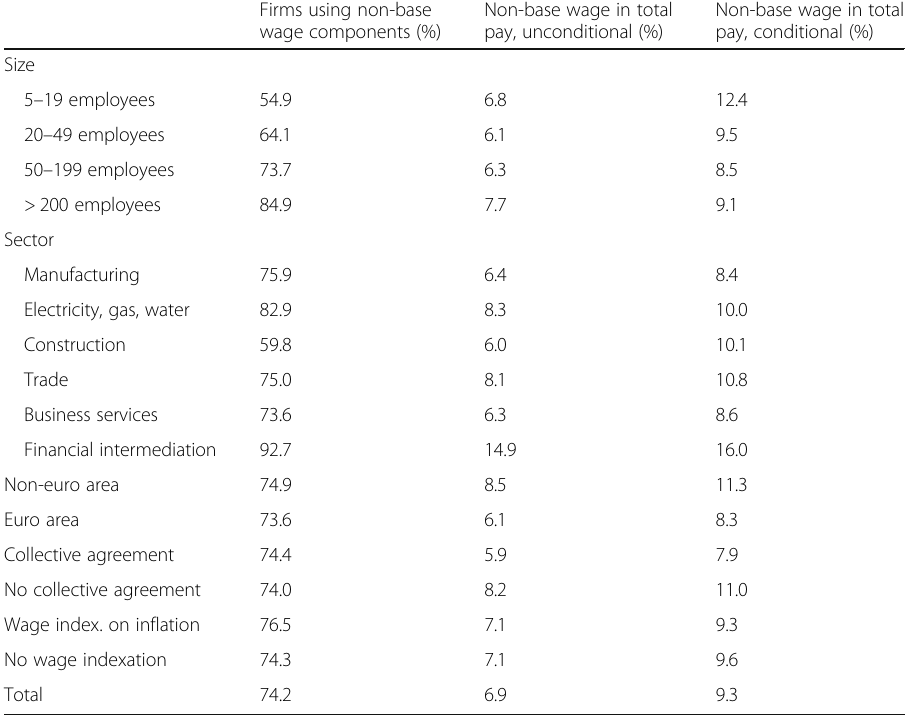
Table 1 Non-base wage components by firm size and sector in 2013